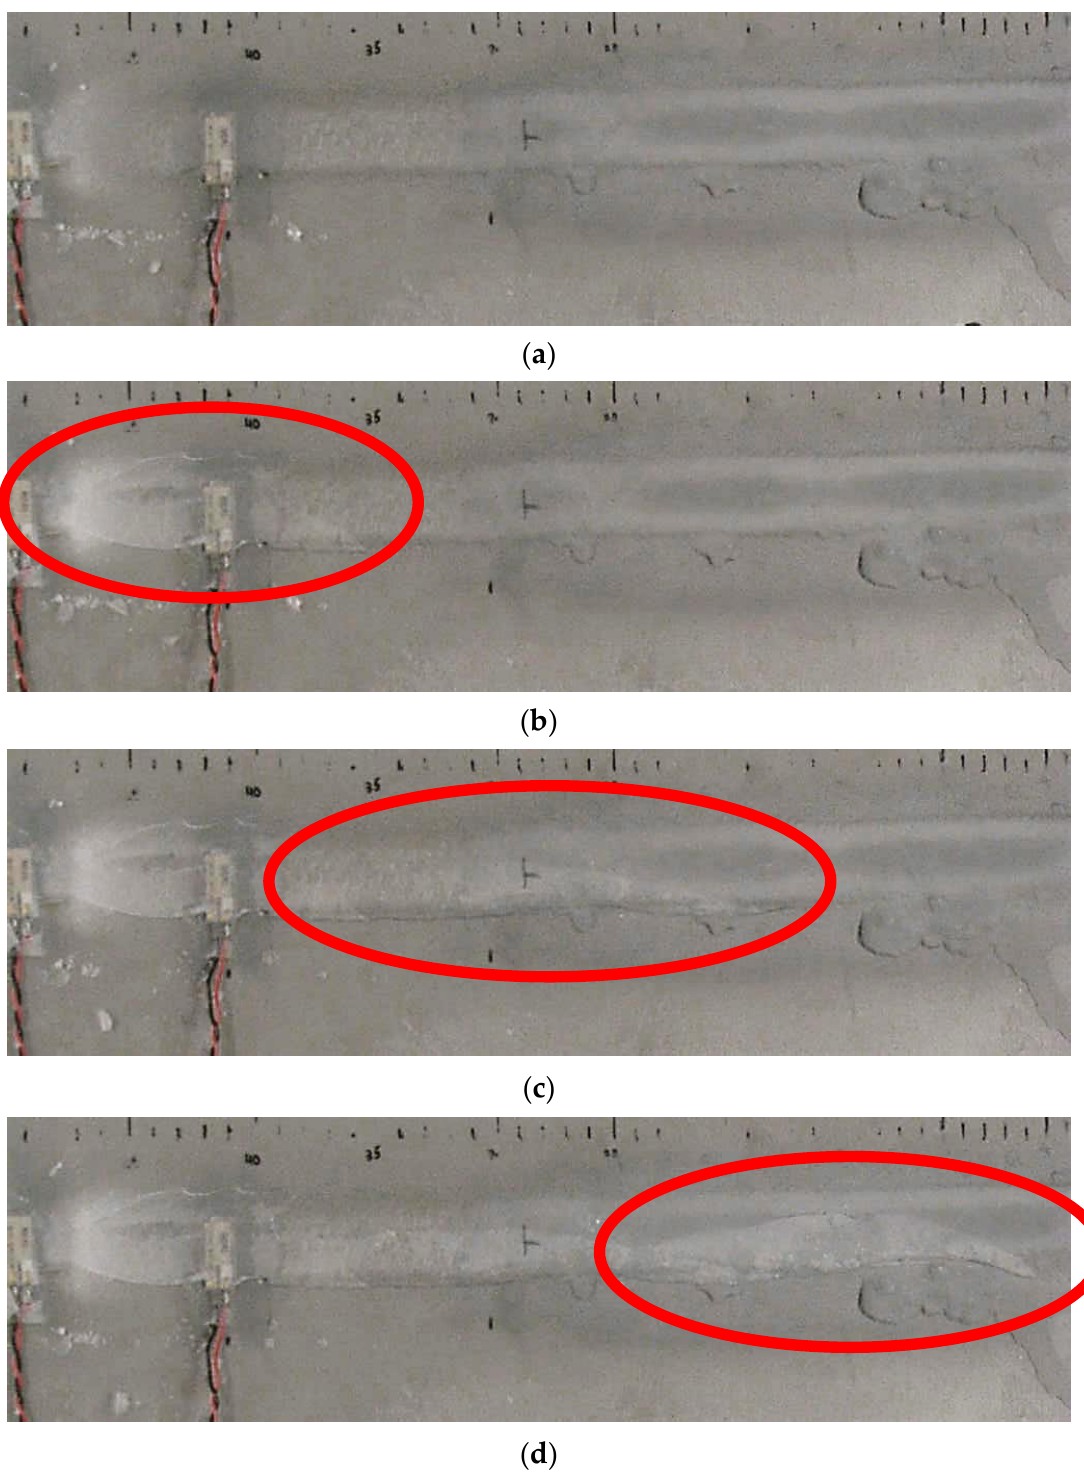
Figure 12. Pictures captured after 13.265 ( a ), 13.333 ( b ), 23.999 ( c ) and 25.799 s ( d ) with the camera during a frequency sweep from 1000 to 1500 Hz in 60 s with the five actuators activated in phase at 600 Vpp.